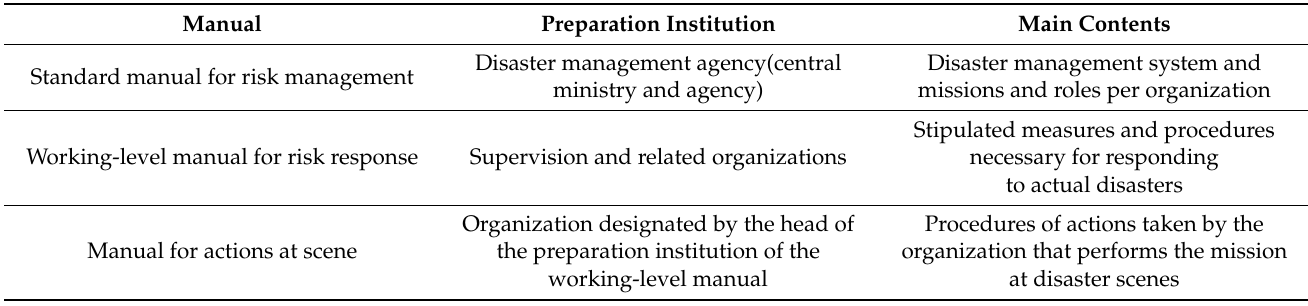
Table 1. Risk management manual